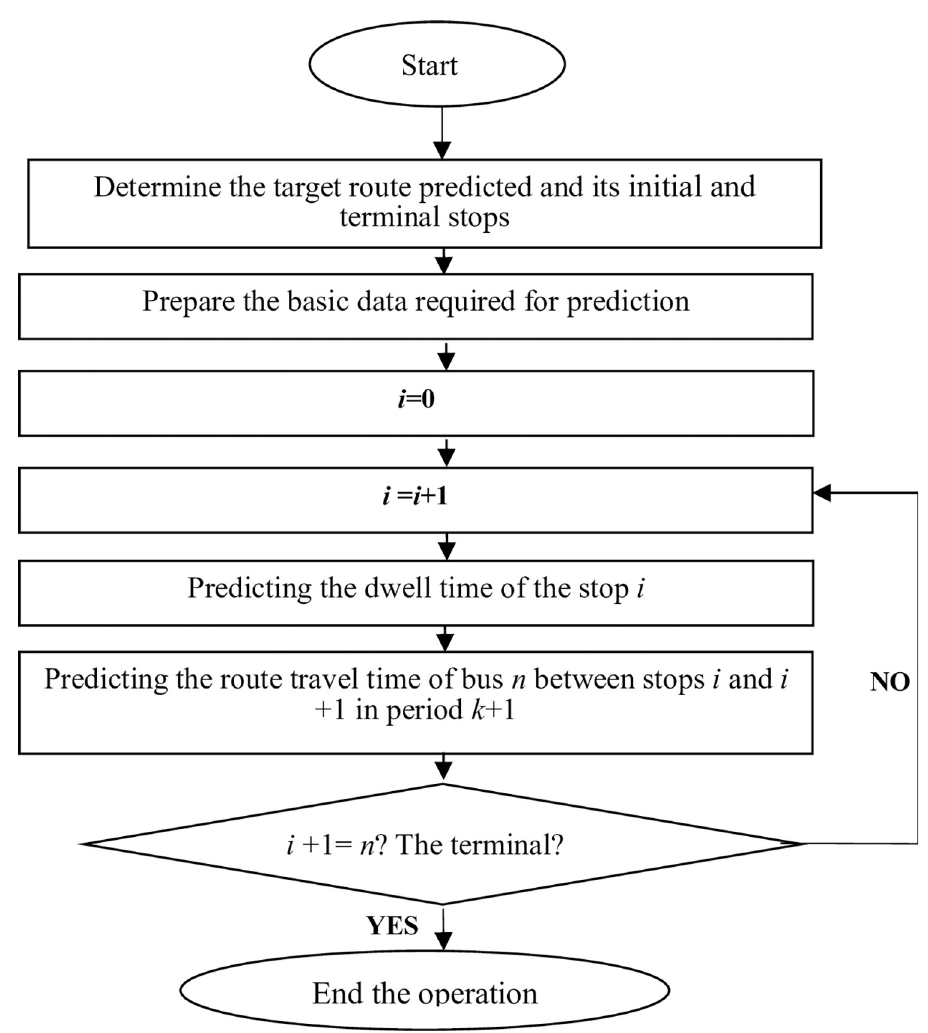
Fig 4. Travel time prediction process based on single route